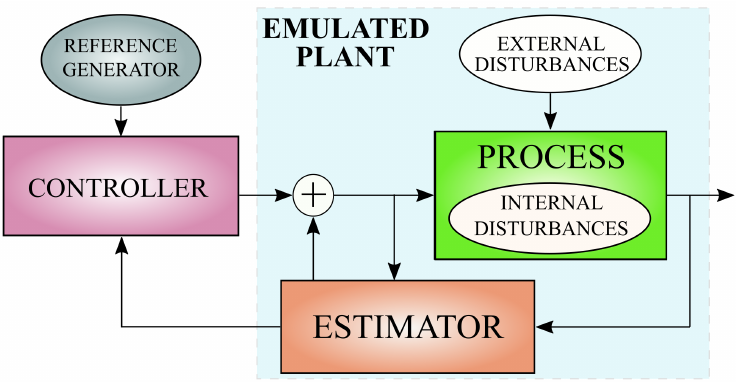
Figure 5. General idea of the ADRC